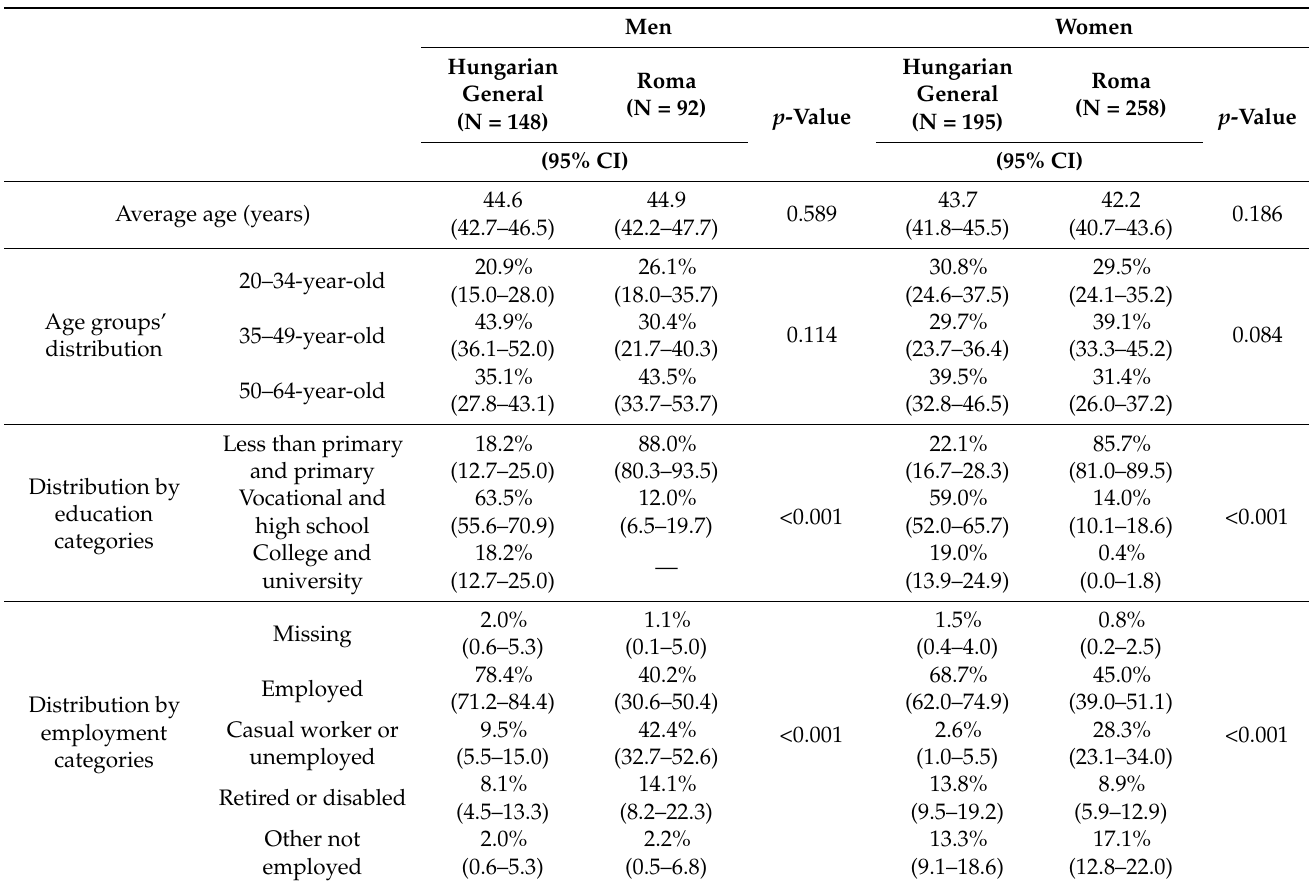
Table 1. Socio-demographic characteristics of the sample populations by